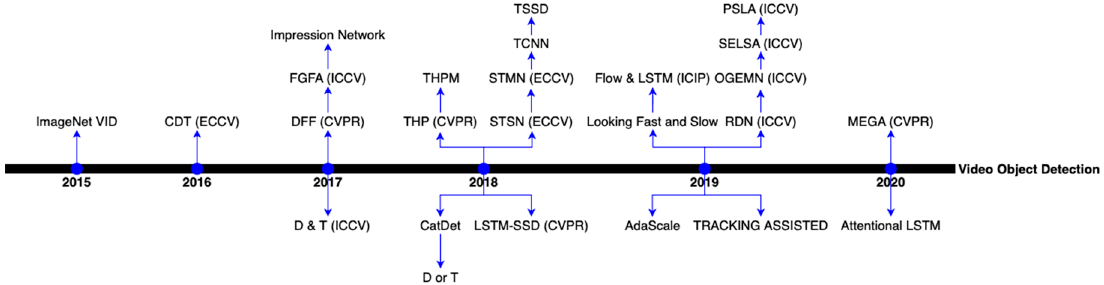
Figure 11. Timeline of video object detection methods. Appl. Sci. 2020 , 10 , x FOR PEER REVIEW